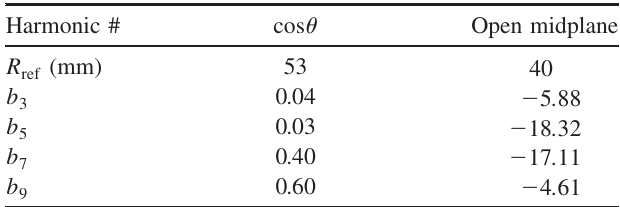
TABLE V. Geometrical harmonics ( 10 (cid:2) 4 ).